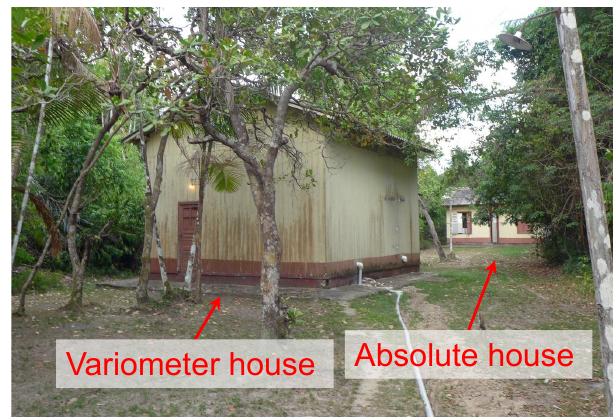
Figure 2. Satellite image of Tatuoca island and its surroundings (Copyright 2017 Landsat/Copernicus, TerraMetrics and Google). The city of Belém is located to the south of Tatuoca island and the observatory.